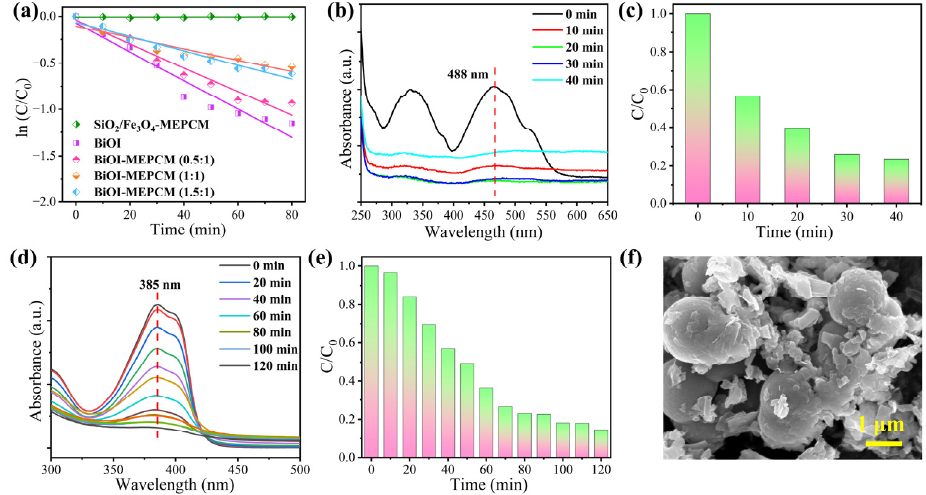
Figure 8. ( a ) ln ( C / C 0 ) as a function of irradiation time during the photocatalytic process. ( b ) UV–vis absorption spectra and ( c ) photocatalytic degradation of Congo red during the photocatalytic process with BiOI-MEPCM. ( d ) UV–vis absorption spectra and ( e ) photocatalytic degradation of tetracycline during the photocatalytic process with BiOI-MEPCM. ( f ) SEM micrograph of BiOI-MEPCM after stirring by a rotor-stator homogenizer.